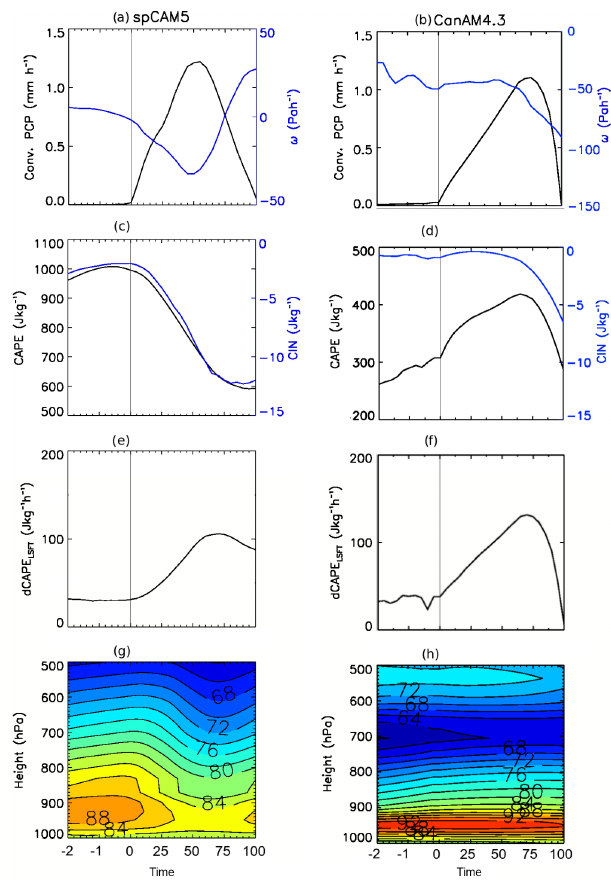
Figure 4. Prior to time = 0, the time on the x axis is in hours. Af- ter time = 0, the time is in % of the event duration time. The rain events start at time = 0 and end at t = 100. The y axis on the left shows values for the black curves and the y axis on the right shows values for the blue curves. The panels on the left (a, c, e, g) are for spCAM5 and the panels on the right (b, d, f, h) are for CanAM4.3. The first row (a, b) shows convective precipitation and large-scale near-surface ω ; the second row (c, d) shows CAPE and CIN; the third row (e, f) shows dCAPE LSFT and the fourth row (g, h) shows relative humidity